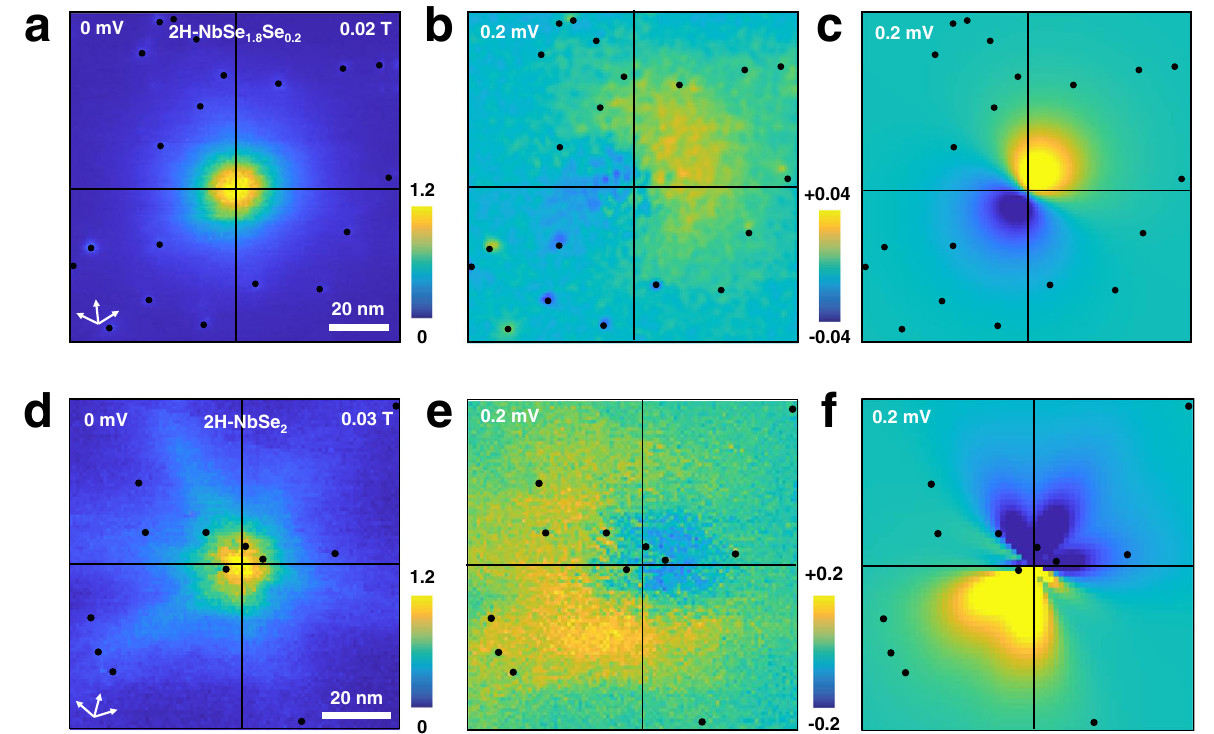
Fig. 4 Vortex cores coupled with YSR states. a Zero bias conductance map of a vortex in 2H-NbSe 1.8 S 0.2 . b Map showing the difference between the normalized tunneling conductance at positive and negative bias voltages δ G ð r ; V Þ G obtained from the calculation described in the text. The same quantities are plotted for 2H-NbSe 2 in d , e , and f . Color scales are given by the bars on the right side of panels a and d for the zero bias conductance, and in between panels b , c and e , f for δ G ð r ; V Þ G centers are at the crossing point between the black lines. White arrows in a , b give the directions of the Se